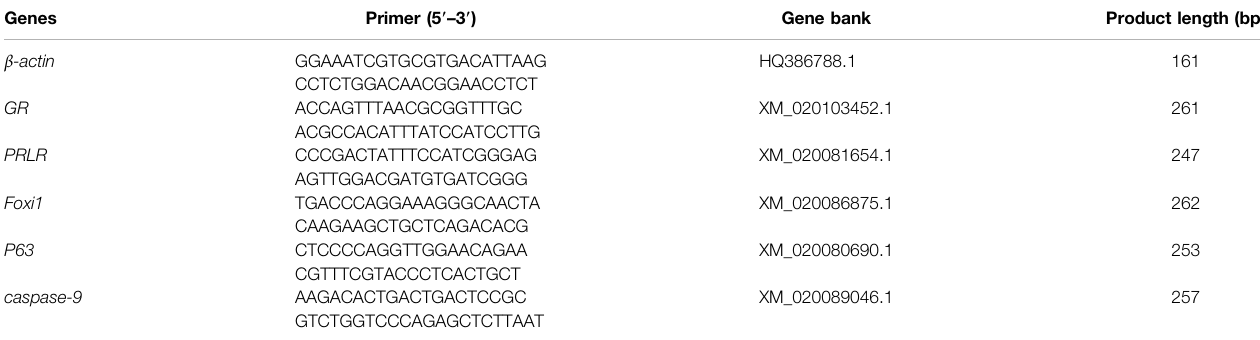
TABLE 1 | Primer sequences used for real-time PCR ampli fi